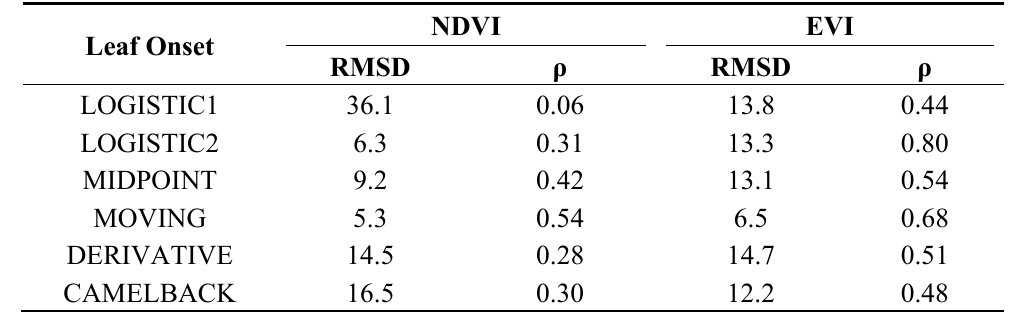
Table 3. Performance of remotely sensed